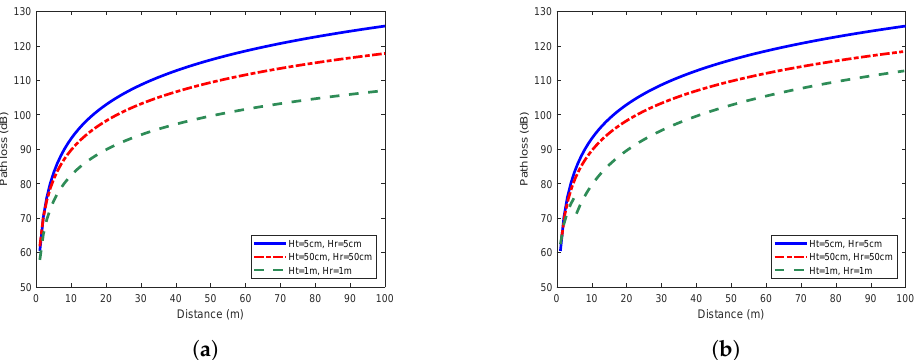
Figure 4. Path loss models under the flat concrete road scenario: ( a ) one-slope model; and ( b ) two-slope model.